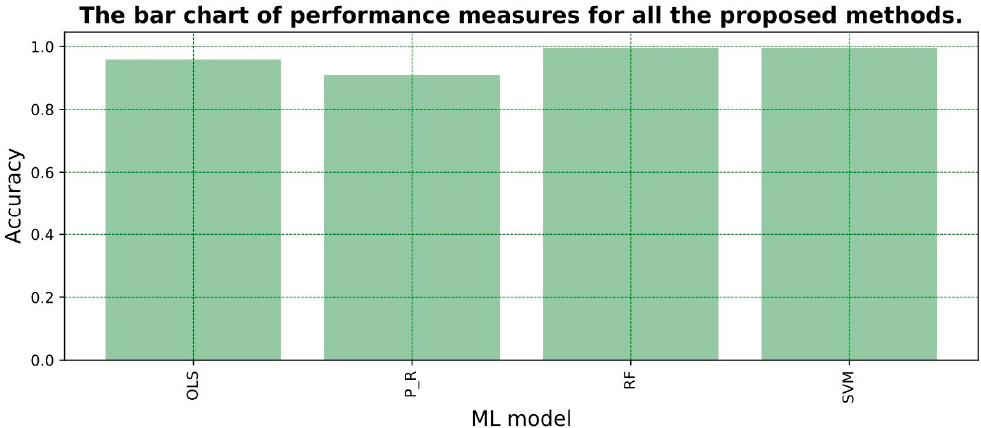
Figure 4. Bar chart of the performance measures for the proposed ML techniques.